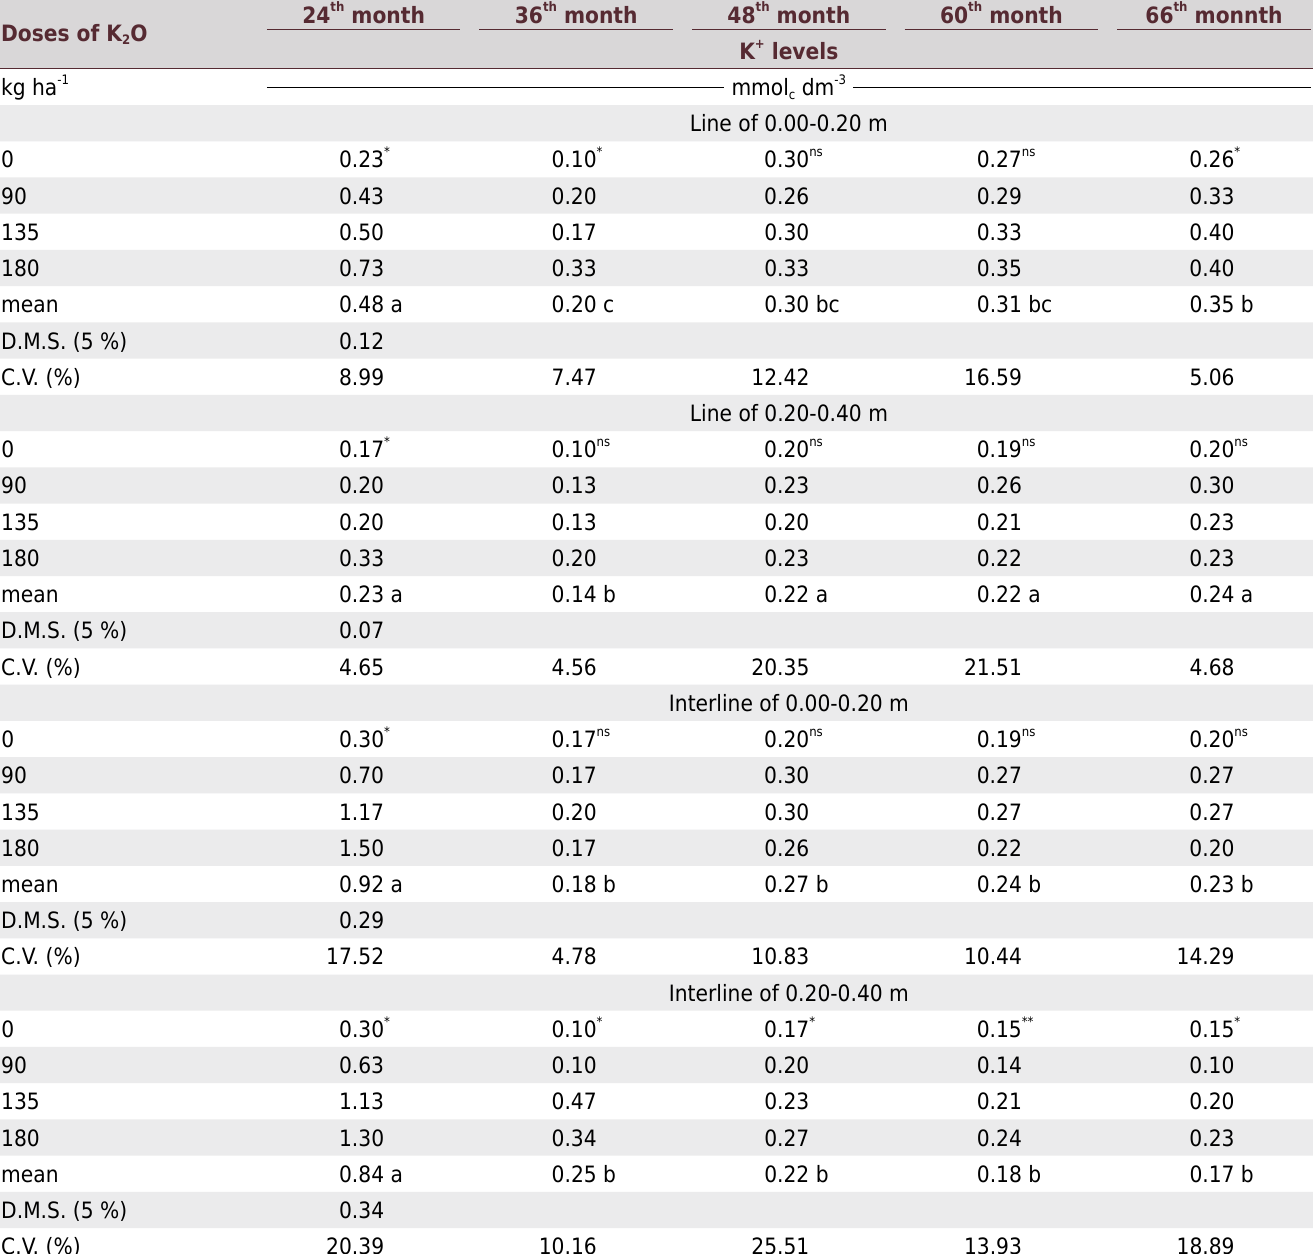
Table 1. Potassium levels in the soil in the planting line and in the interline of E. urophylla hybrid at layer of 0.00-0.20 and 0.20-0.40 m, evaluated at 24, 36, 48, 60, and 66 months after planting, as a function of doses of K 2 O Doses of K 2